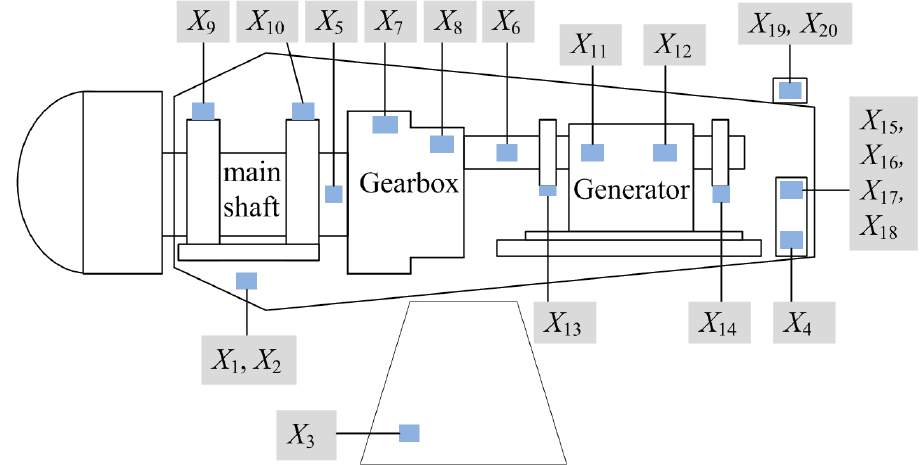
Figure 2. Location of part of measurements by the SCADA